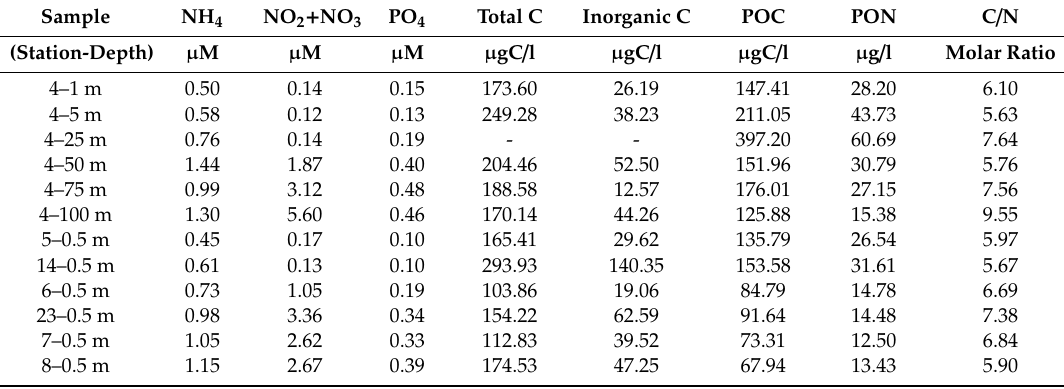
Table 2. Concentrations of trophic variables: inorganic compounds (ammonium NH 4 , nitrites NO 2 + nitrates NO 3, and orthophosphate PO 4 ), Total Carbon, Inorganic and Particulate Organic Carbon (POC), Particulate Organic Nitrogen (PON), and C/N molar ratio measured at the examined stations.